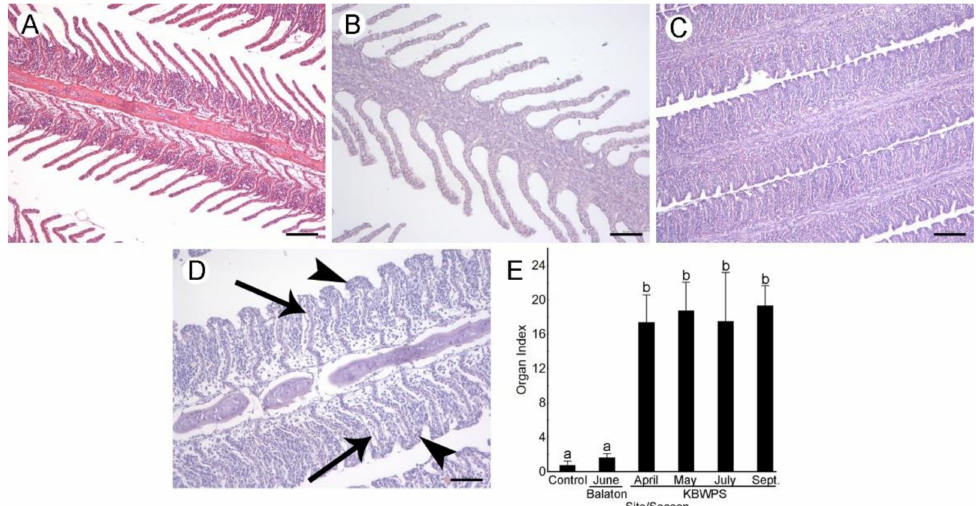
Figure 5. Histopathological alterations of gills of fish caught from Lake Balaton and Kis-Balaton Water Protection System (KBWPS). ( A ) Control individuals demonstrating normal gill histology. ( B ) Individuals from Lake Balaton showing slight tubular clubbing of lamellae and occasional aneurysms. ( C ) Individuals from KBWPS displayed severe hyperplasia of the interlamellar cell mass which led to a complete fusion of lamellae. Occasionally, fusions were also coupled with epithelial lifting ( D ; arrows) and epithelial hypertrophy ( D ; arrowheads). H&E staining. Scale bars: ( A , C , D ): 100 µ m, B : 50 µ m. ( E ) Gill indices obtained after the semi-quantitative analysis of the histopathological alterations. Different letters above the SD bars indicate statistical significance (Tukey’s HSD, p <